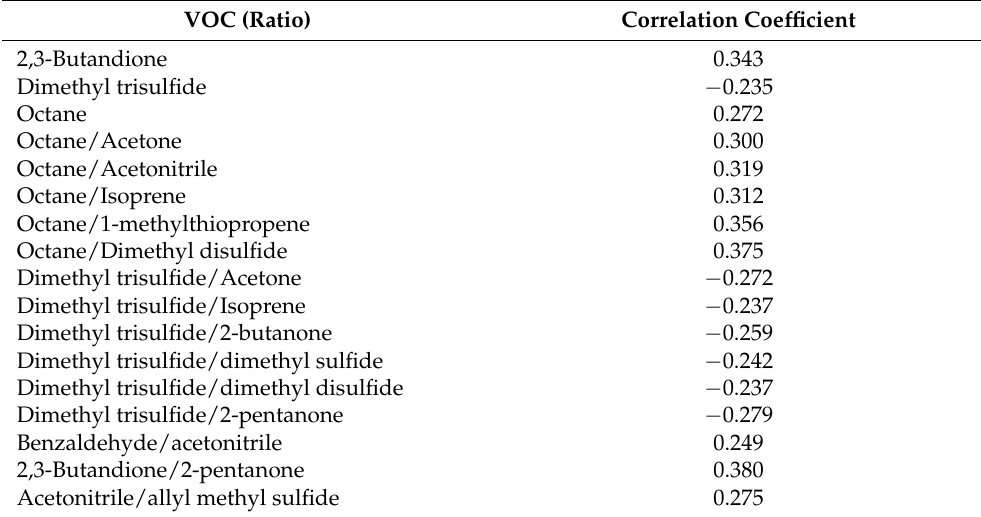
Table 4. Correlation coefficients between VOCs (their ratios) and TNM stage.